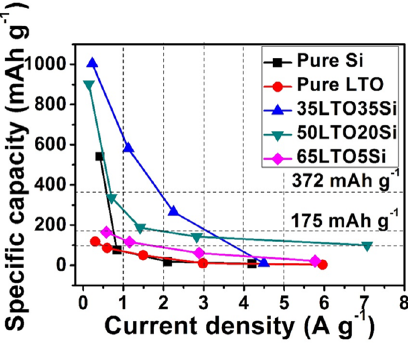
Figure 4. Relationship between capacities and current densities for all